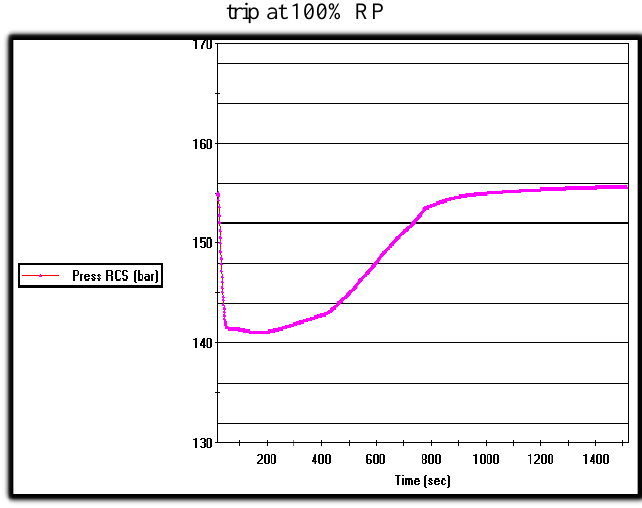
Fig. 12. Transient thermal and nuclear powers under reactor